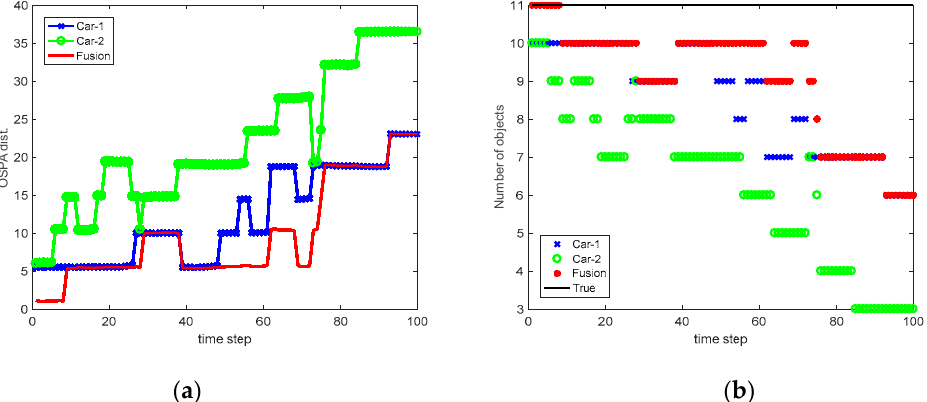
Figure 11. Results in a simulation run. ( a ) Variation of OSPA distance; ( b ) Variation of the number of objects.